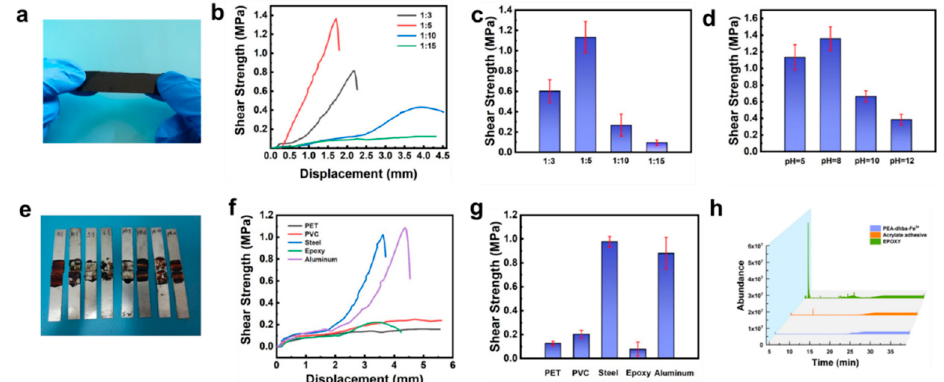
Figure 3. ( a ) Photograph of PEA-dhba-Fe 3+ film; ( b ) shear strength plotted against displacement of PEA-dhba with various ratios of catechol:Fe 3+ and ( c ) corresponding shear strength comparison; shear strength of samples adhered to aluminum by pasting PEA-dhba-Fe 3+ with various ( c ) feed ratios of Fe 3+ :dhba and ( d ) pH values; ( e ) photographs showing stretched lap-shear samples; ( f ) shear strength plotted against displacement of PEA-dhba-Fe 3+ on various substratum and ( g ) corresponding shear strength comparison; ( h ) GC-MS chromatograms for VOCs released from PEA-dhba-Fe 3+ , acrylic, and epoxy adhesives.